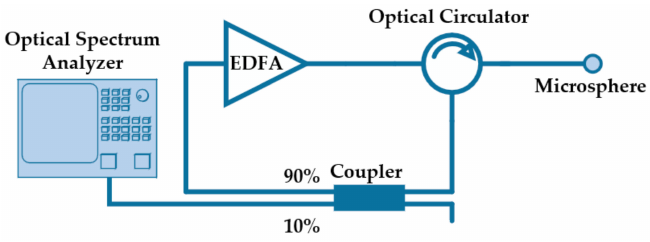
Figure 4. Schematic diagram of the ring structure for random lasing, using asymmetric microspheres.